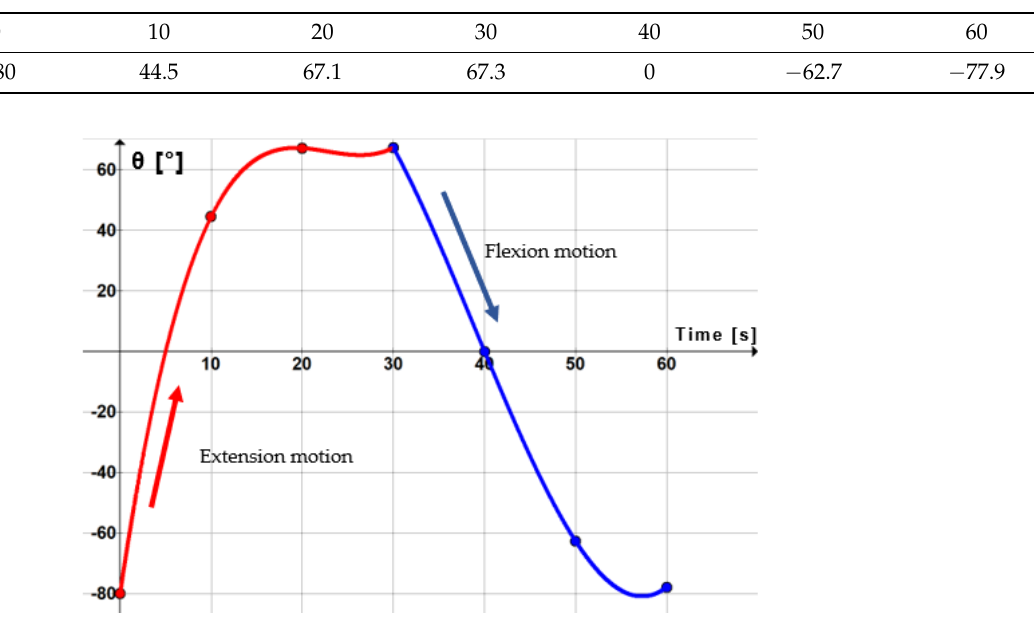
Figure 17. Variation versus time of the wrist rotation angle.